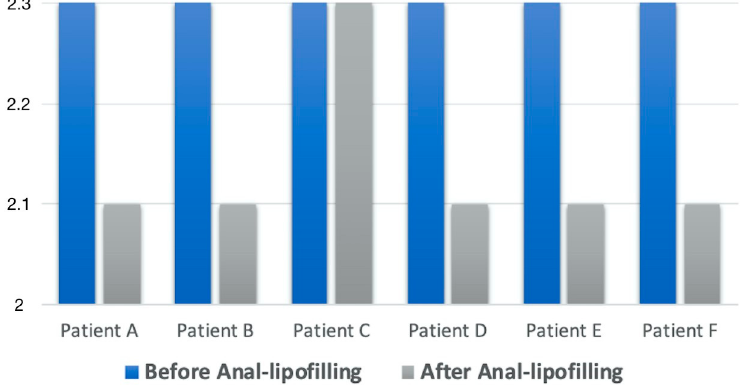
Figure 4. Results of anal lipofilling on soiling reported as the Krickenbeck scale (KS) score.